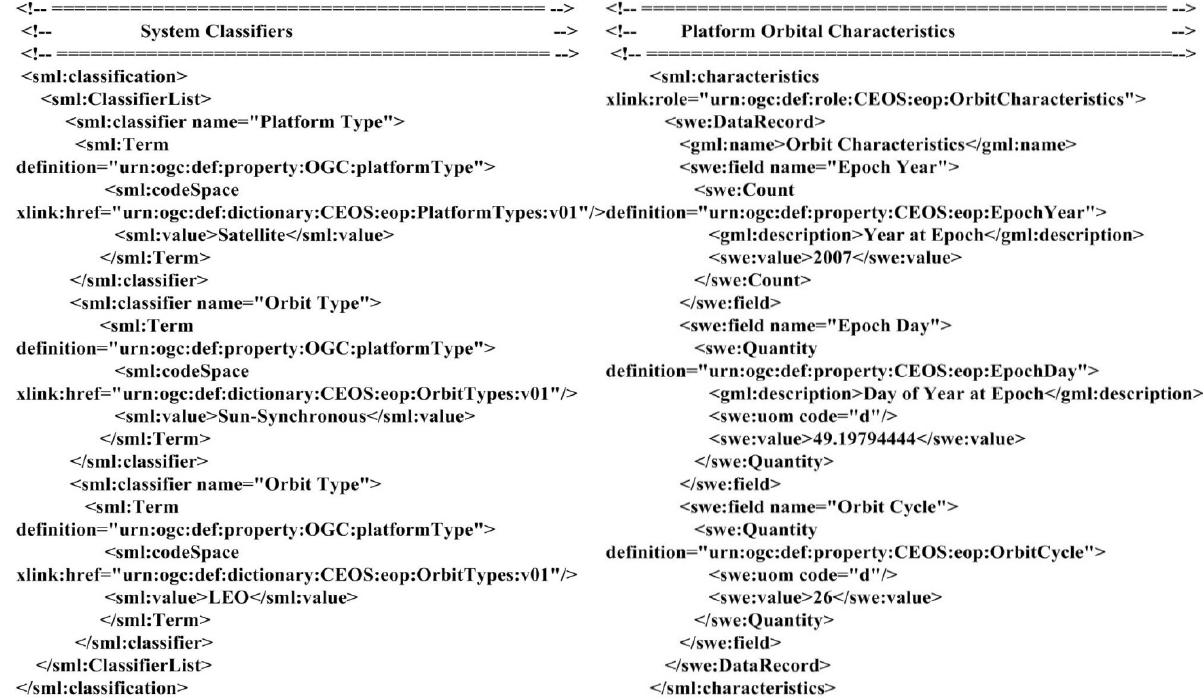
Figure 12. Part of the SensorML code regarding the sensor description.